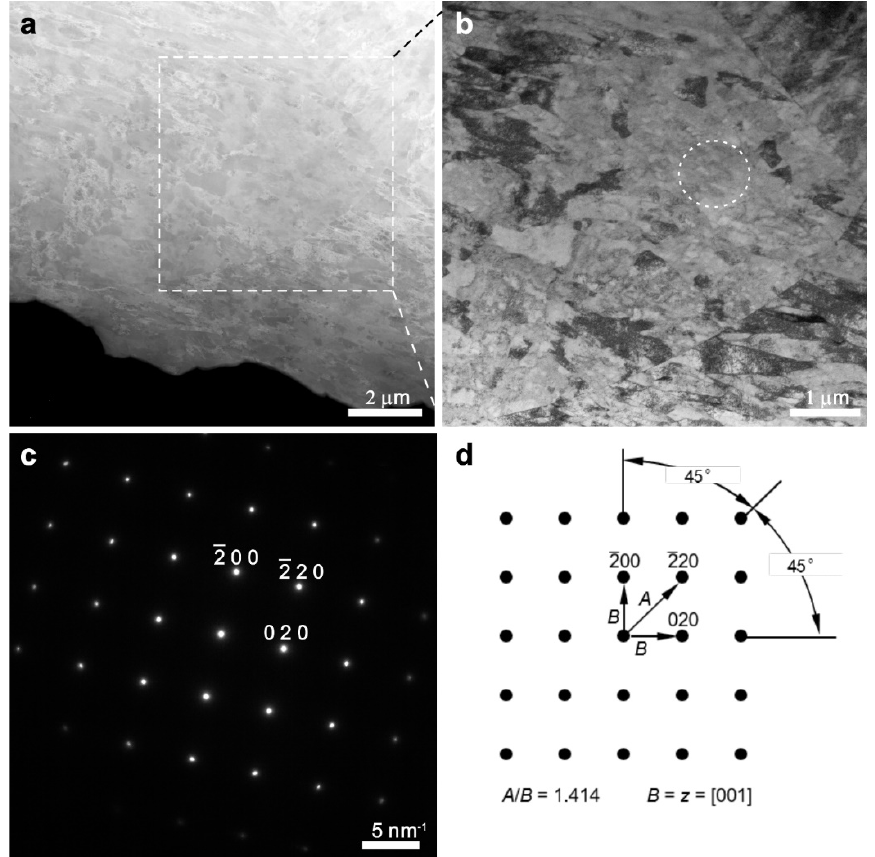
Figure 3. ( a ) Scanning transmission electron images and ( b ) bright field TEM images of the weld fusion line. ( c ) Selected area diffraction patterns of the area indicated by the white dashed circle in ( b ). ( d ) Standard diffraction patterns for face-centered cubic microstructure along the [0 0 1] axis. Note that the position of the TEM sample is indicated by the white dashed circle in Figure 1b. The white dashed square in ( a ) indicates the area for the bright field TEM image of ( b ). The white dashed circle indicates the area for selected area electron diffraction.